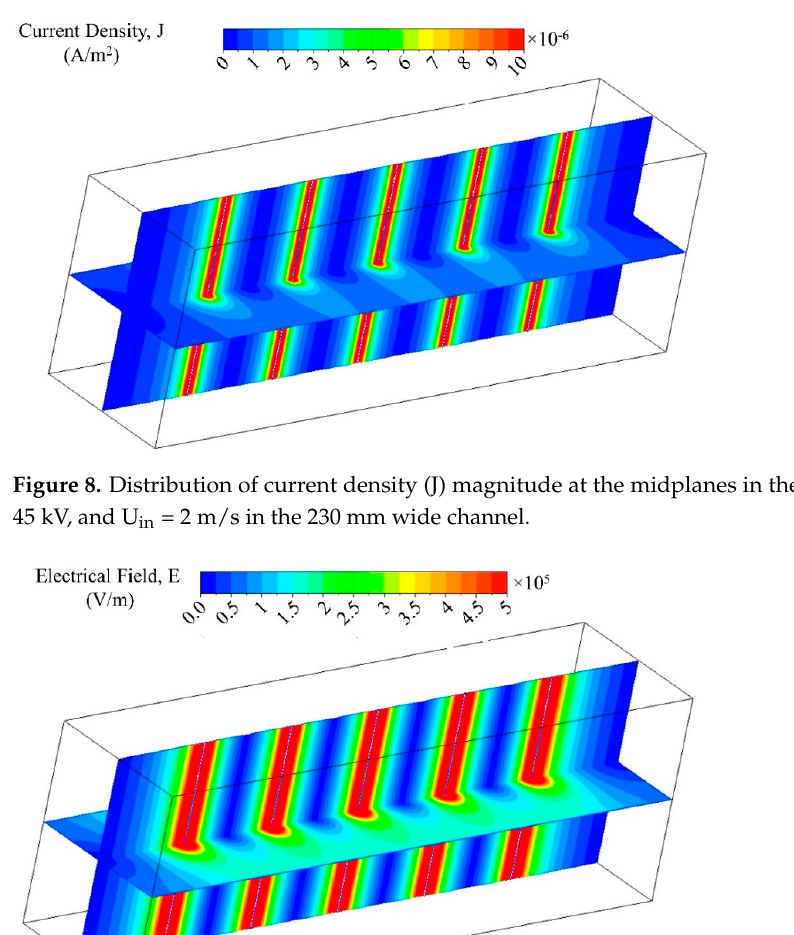
Figure 7. Distribution of electric potential values at the midplanes in the case of d w = 1 mm, 45 kV, and U in = 2 m/s in the 230 mm wide channel.